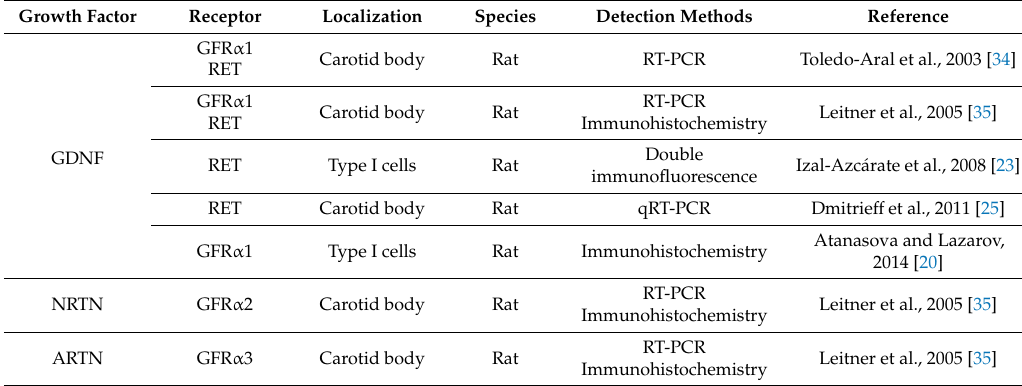
Table 4. Glial cell line-derived neurotrophic factor family receptors. Expression of GFR α 1-3 and RET in the carotid